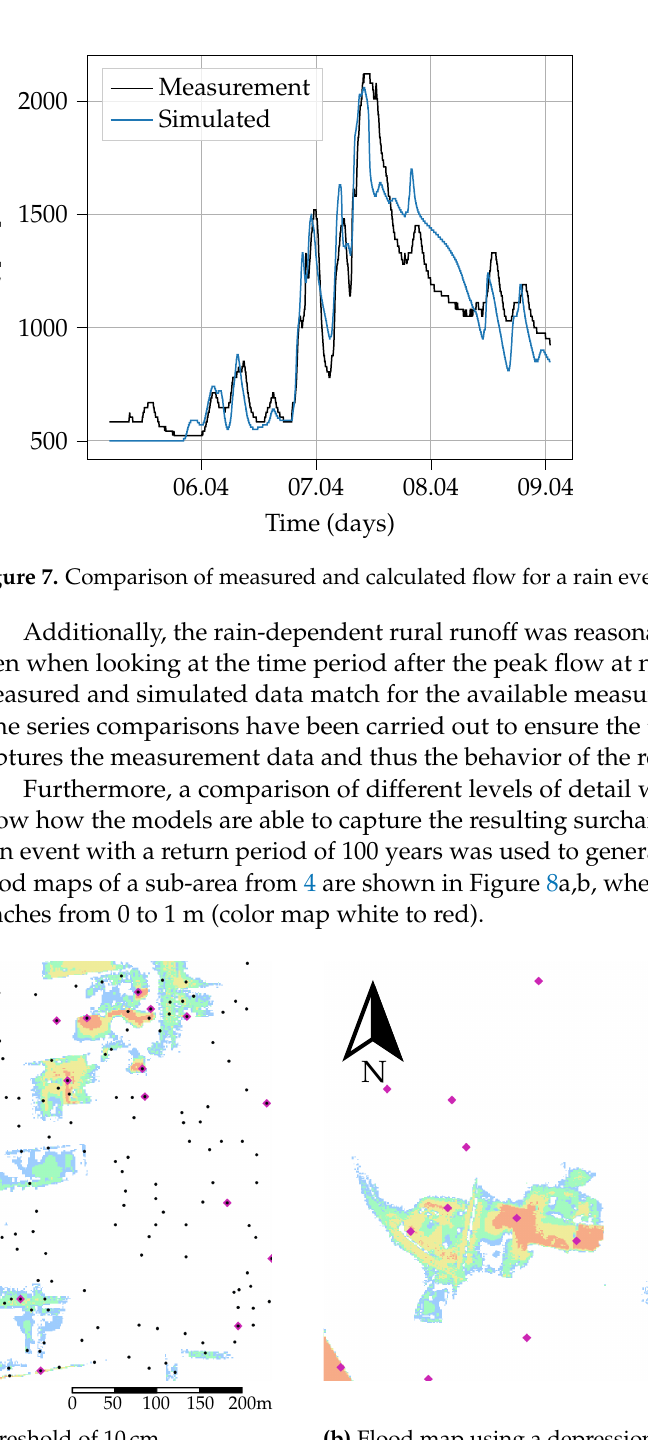
Figure 8. Flood maps of a 100-year event with different depression thresholds for the surface modelling. The subarea center points of a 10cm and 30cm depression are marked with black dots and mangeta squares, respectively. The surcharge water level reaches from 0 to 1 m (color map white to